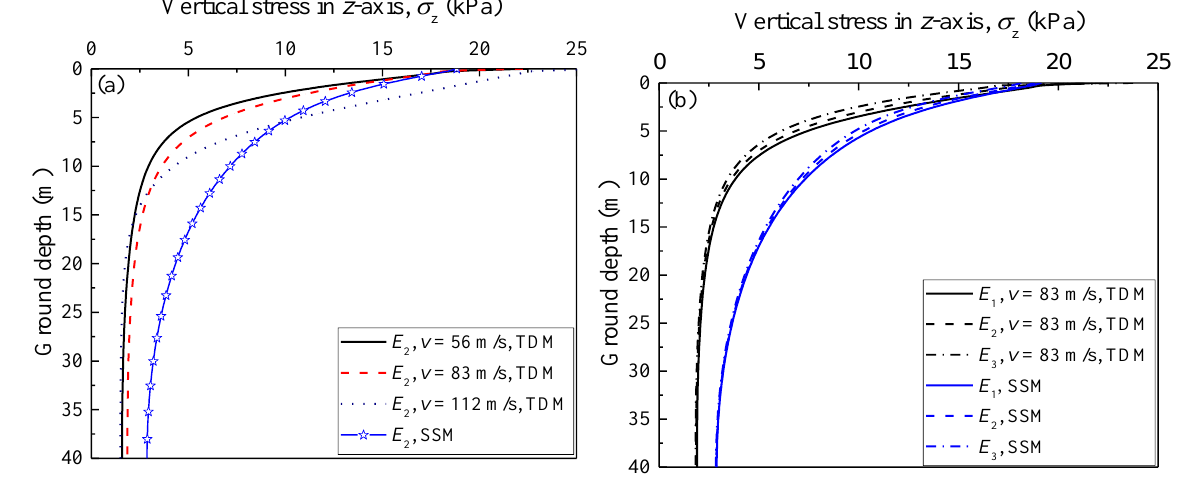
Figure 18. Relationship between vertical stress and ground depth with different train speeds and embankment stiffnesses: ( a ) train speed; ( b ) embankment stiffness.